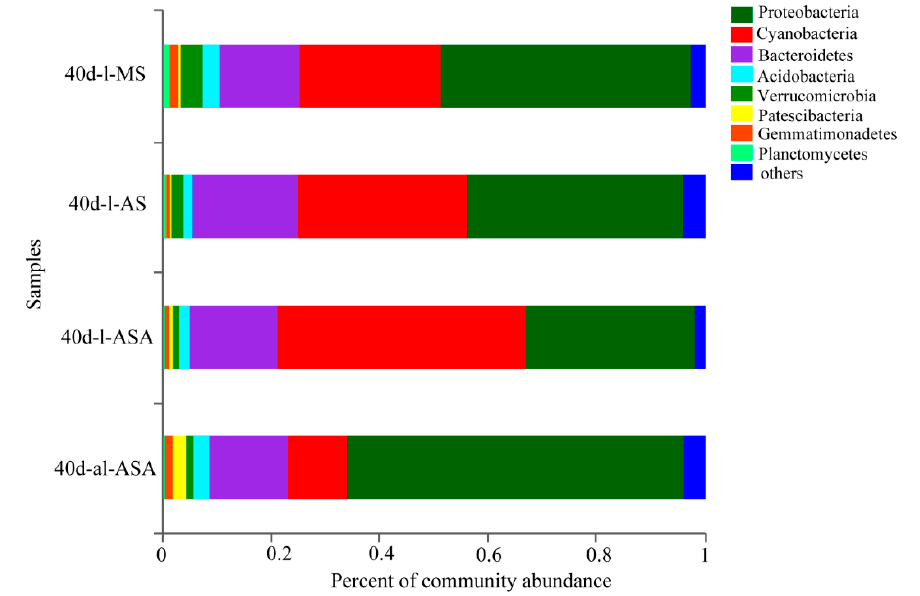
Figure 10. Community bar plot analysis of leaves on phylum level. (Notes: 40d-l-MS is leaf of the last day in group MS, 40d-l-AS is leaf of the last day in group AS, 40d-l-ASA is leaf of the last day in group ASA, 40d-al-ASA is artificial aquatic mat leaf of the last day in group ASA.).